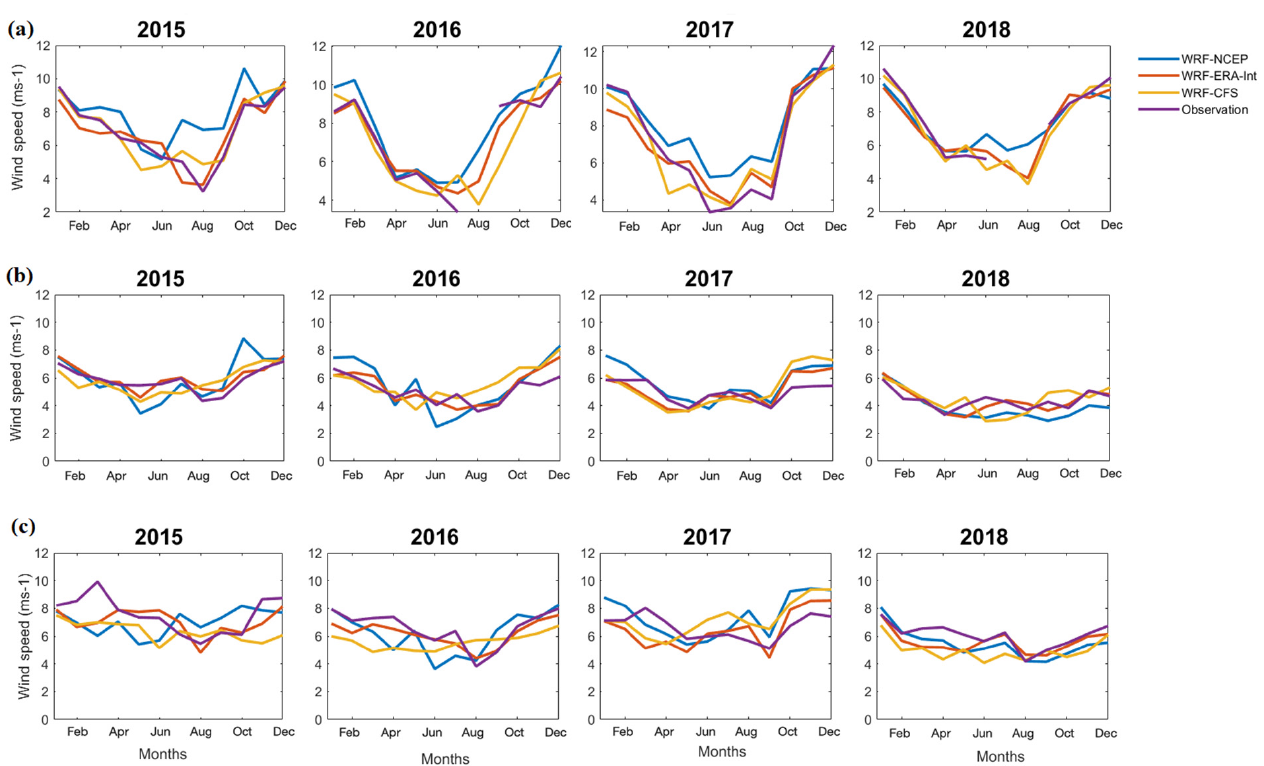
Figure A6. Monthly averaged wind speed in m s − 1 from the models and observations at the offshore locations ( a ) Quanzhou, ( b ) Shanwei, and ( c ) Nansan.